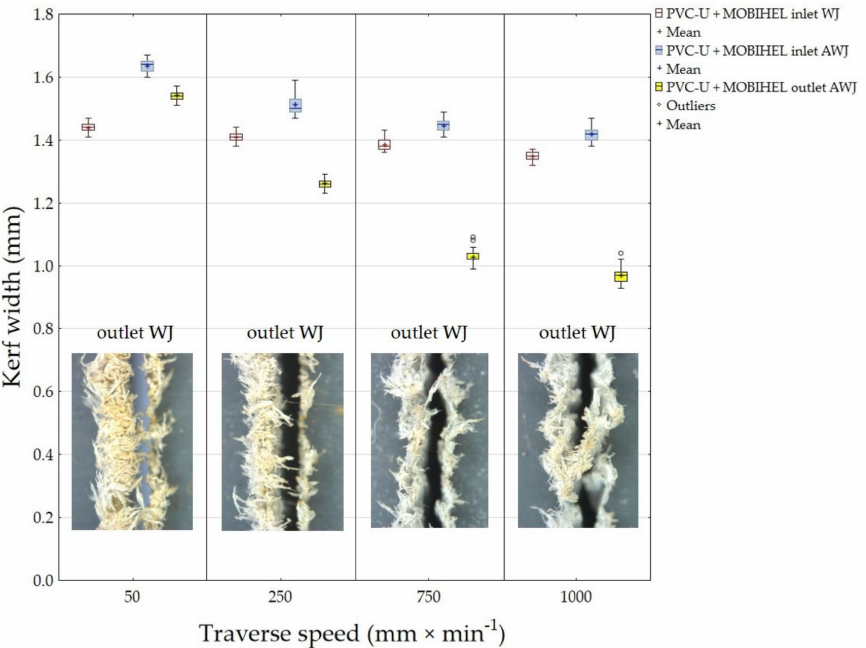
Figure 6. Dependence of the kerf width on the cutting head traverse speed and waterjet type for PVC-U + MOBIHEL.